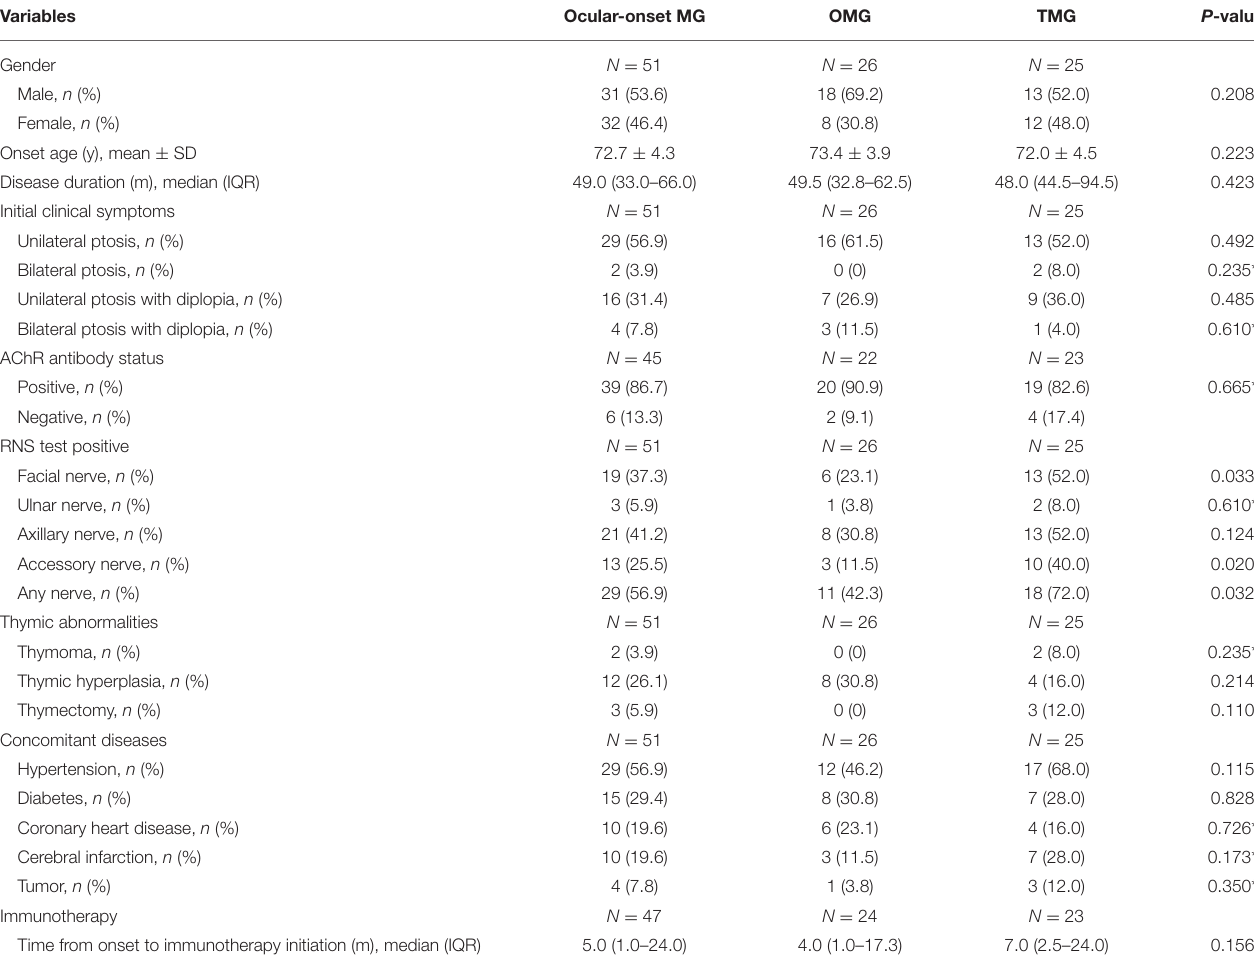
TABLE 2 | Baseline demographic and clinical data of patients with v-LOMG with pure ocular onset. Variables Ocular-onset